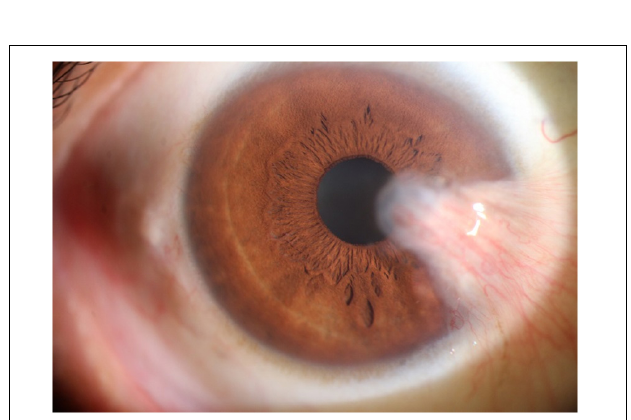
FIGURE 3 | An example of the Operation group (pterygium).